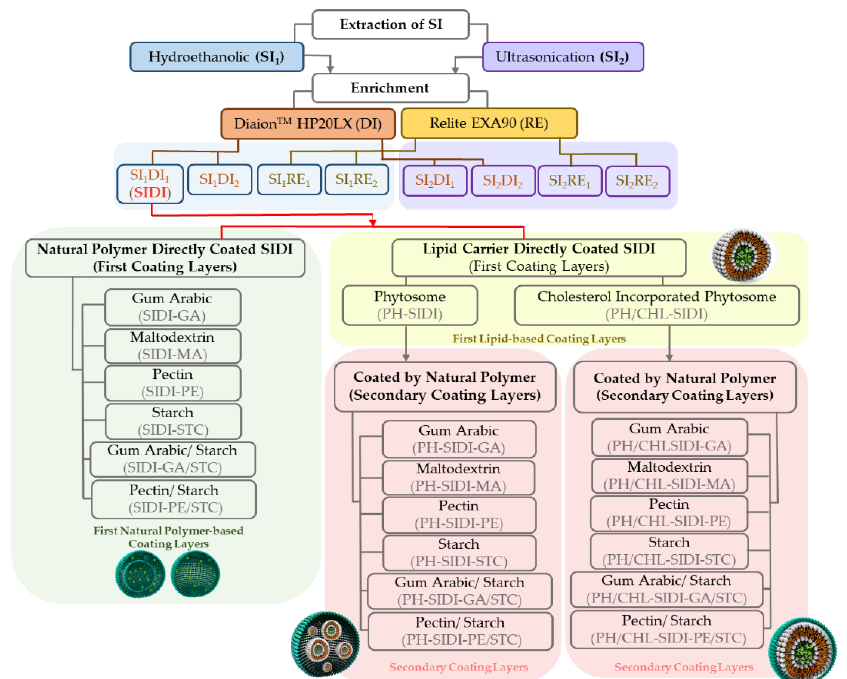
Chart 1. Flow of the preparation steps, regarding the type of extraction, enrichment, and type of coating layer (first or secondary layers). SI, silverskin; DI, Diaion resin; RE, Relite resin; GA, gum Arabic; MA, maltodextrin; PE, pectin; STC, starch; PH, nano-phytosome; PH/CHL, cholesterol incorporated nano-phytosome. Note: DI 1 and RE 1 series are the enriched fractions (regarding caffeine and phenolics contents) obtained with DI and RE, respectively. DI 2 and RE 2 series are the discarded fractions (rich in sugars, chlorophylls, etc.).